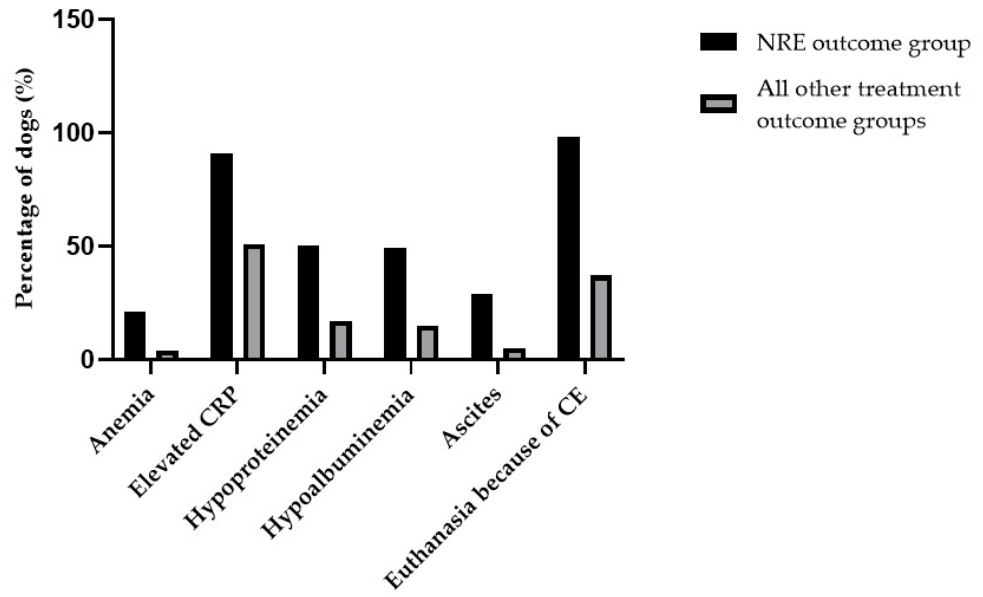
Figure 3. Bar graph that illustrates the characteristics of dogs in the NRE outcome group contrasted to the dogs belonging to the other treatment outcome groups (FRE, IRE, ARE, and non-classified outcome group). Table 2. Summary of laboratory results and ultrasonographic findings in the gastrointestinal (GI) tract by treatment outcome group.